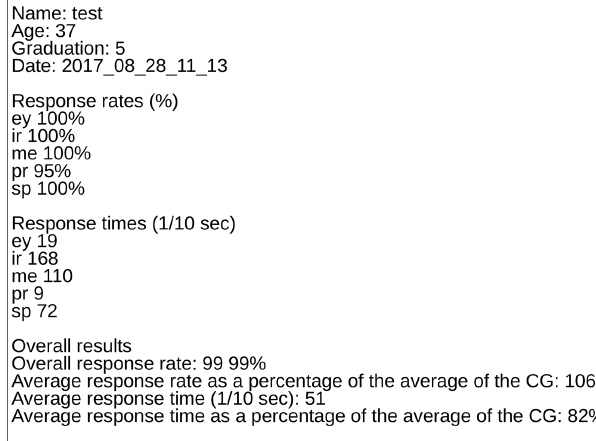
FIgURe 4 | The figure shows an example text file with the overall results of a participant created by Scanalizer.